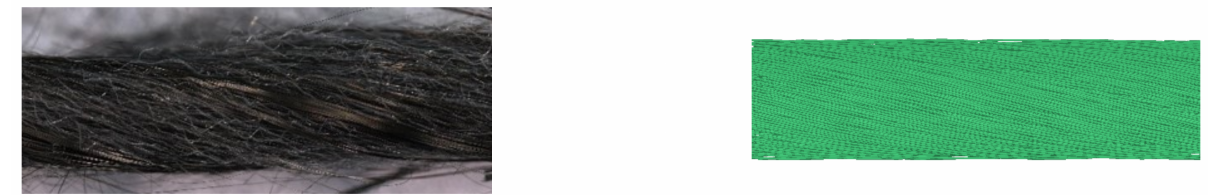
Figure 9. Geometrical validation of yarn geometry ( left : micrograph of hybrid yarn with 30 t/m, right : modeled geometry with 30 t/m).